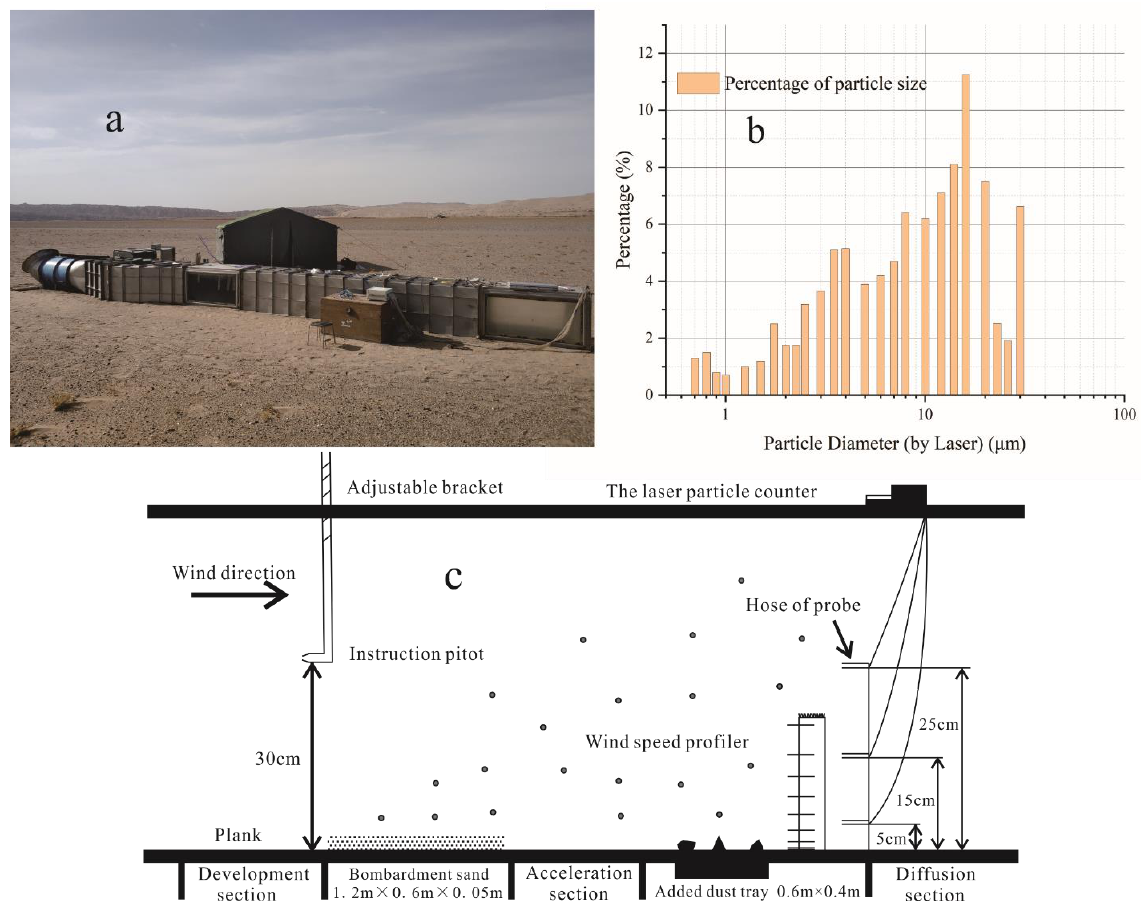
Figure 3. Field wind tunnel ( a ), particle size distribution of the clay soil ( b ), and the experimental layout ( c ).